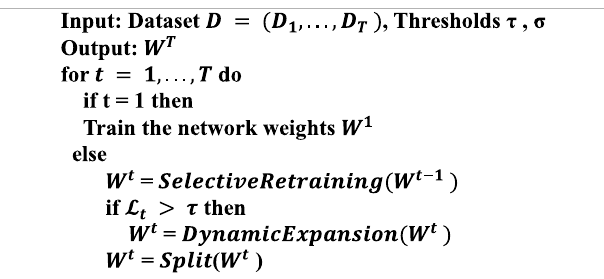
ALGORITHM 1 | Incremental Learning for Dynamically Scalable